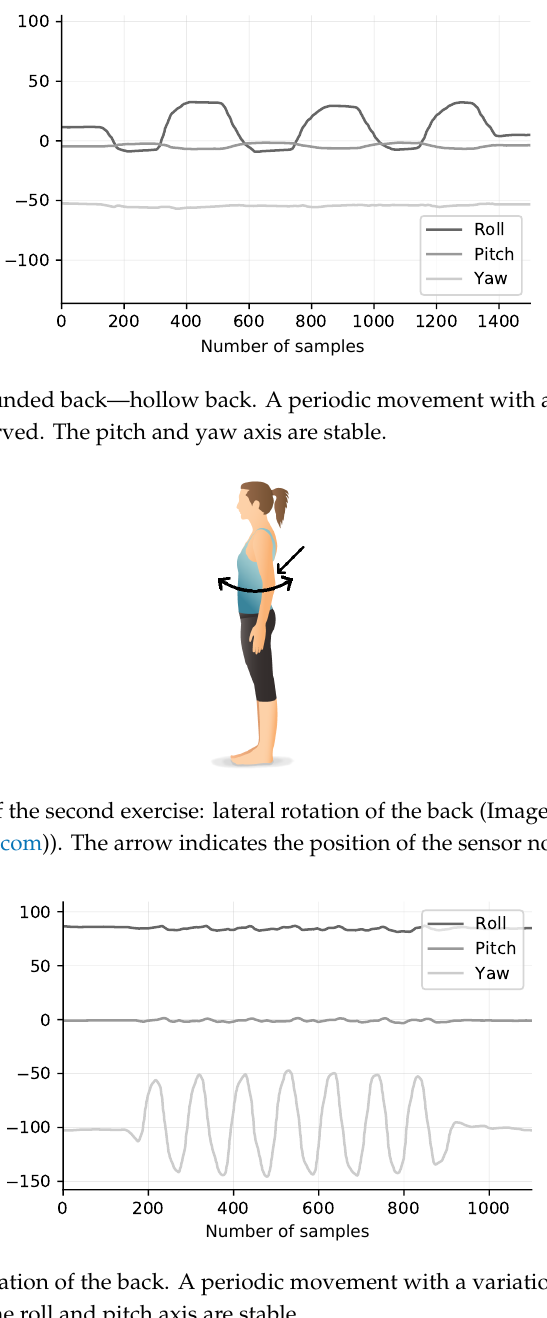
50° on the yaw axis ±